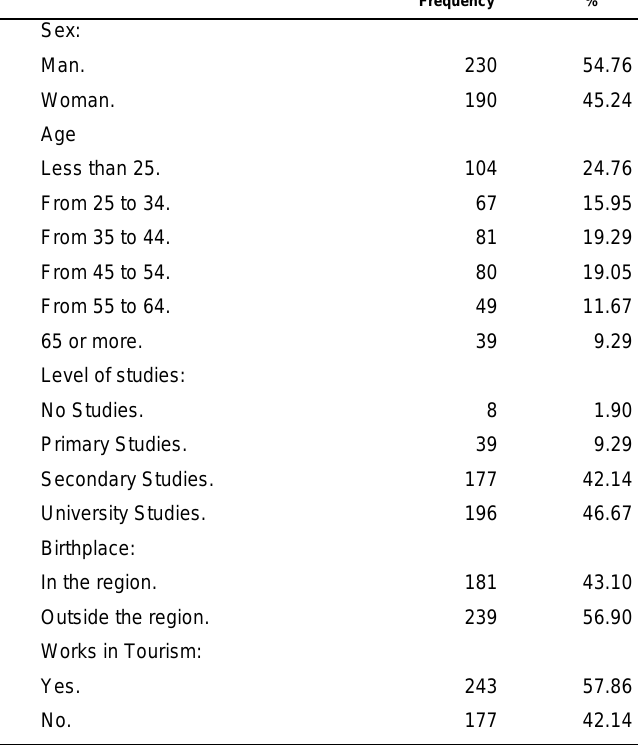
Table 1. Socio-demographic profile of the